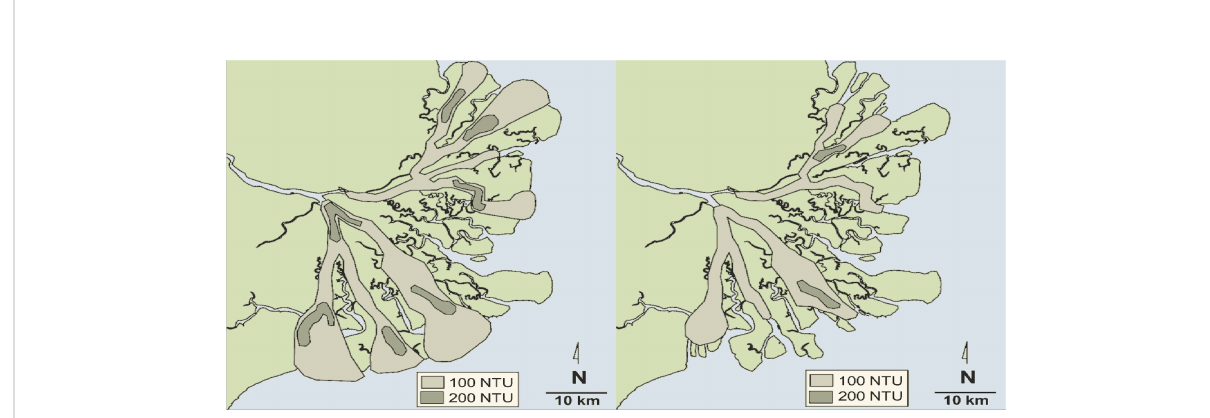
FIGURE 1 Bottom turbidity in nephelometric turbidity units (NTUs) of the Mahakam Estuary in Indonesia during maximum ebb at spring tide (left) and at neap tide (right), adapted from Salahuddin and Lambiase